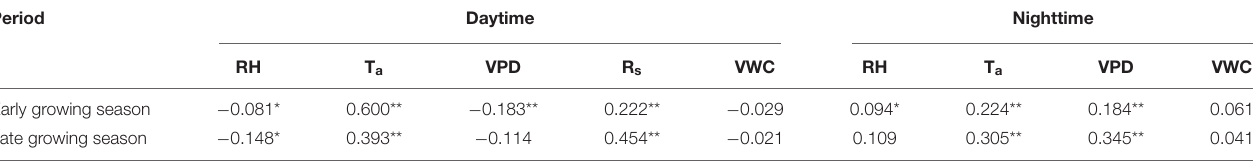
FIGURE 4 | Relationship between daytime and nighttime sap flow velocity in different periods. TABLE 6 | Partial correlation coefficients between sap flow velocity and driving factors at different periods.